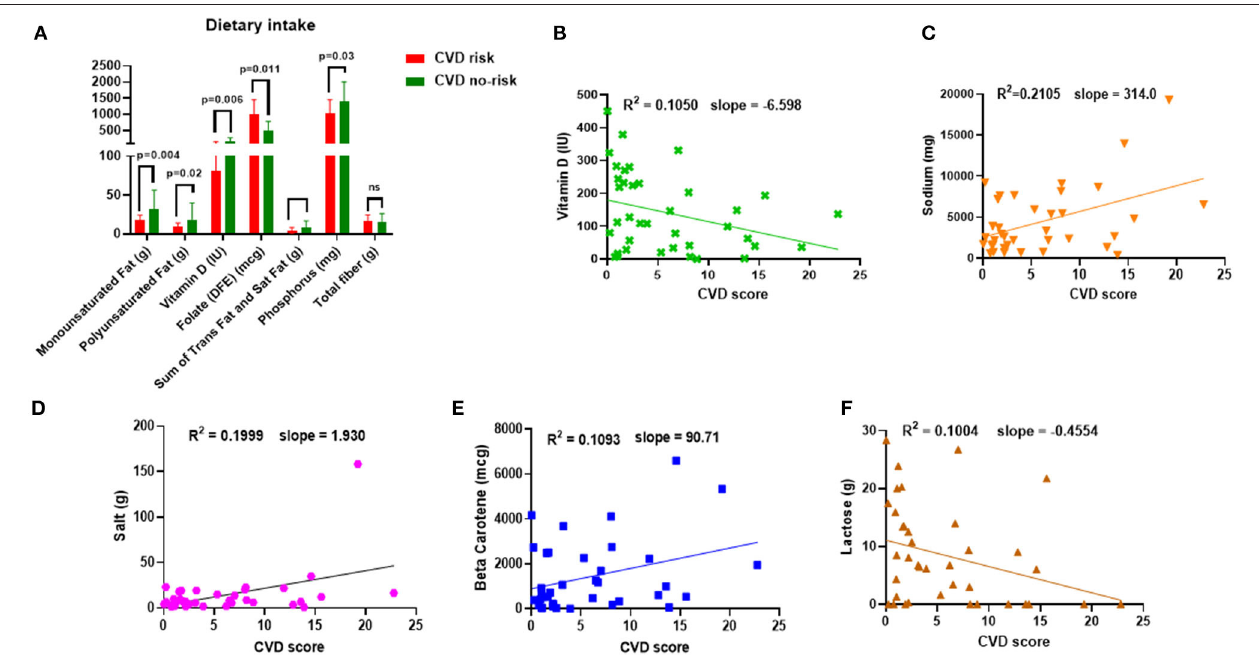
FIGURE 1 | Dietary intake and correlation to CVD risk. (A) Dietary intake of MUFA, PUFA, vitamin D, folate, the sum of trans-fat and saturated fat, phosphorus, and total fiber in the CVD no-risk and CVD risk groups. (B–F) Correlation analysis of nutrient intake (sodium, salt, beta-carotene, lactose, and vitamin D) and CVD risk in the obese population. CVD no-risk N = 30; CVD risk N = 8. P < 0.05 was considered statistically significant using Student’s t-test or Mann-Whitney test was performed, wherever